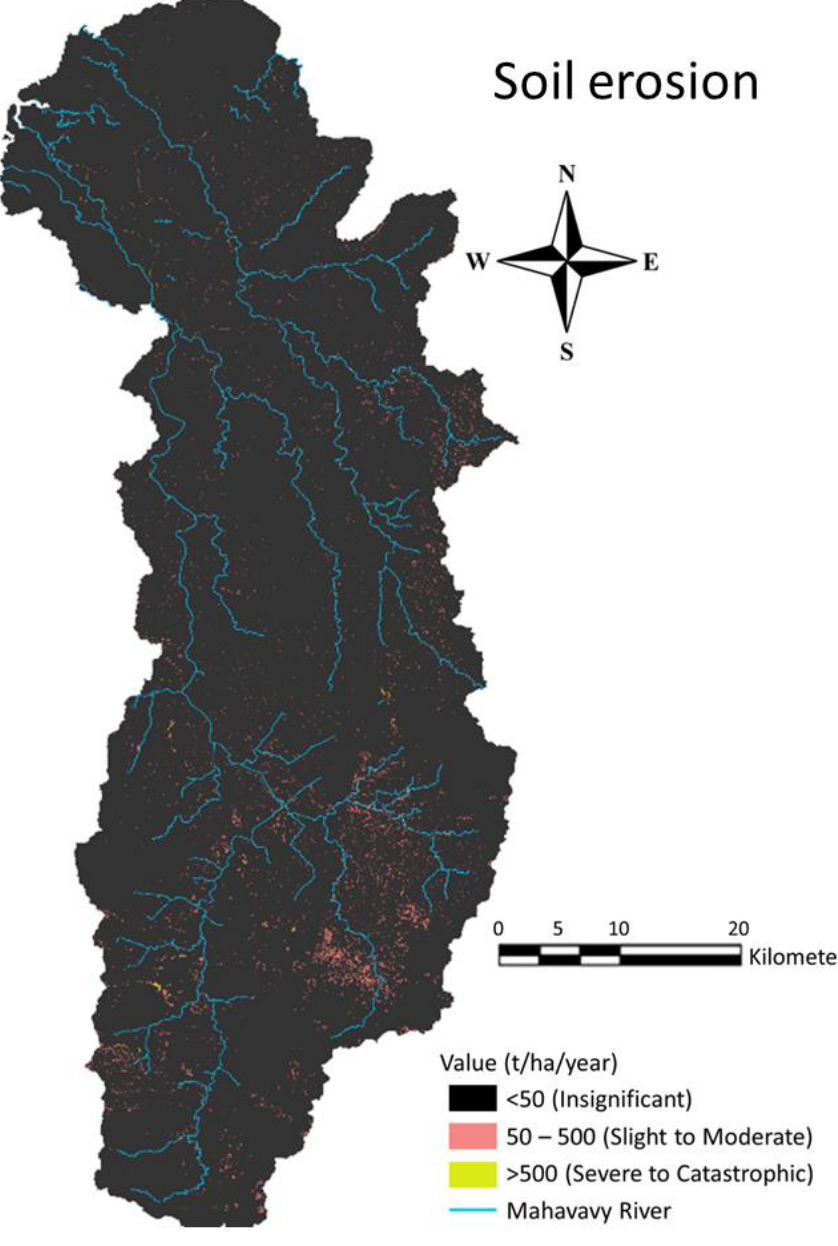
Figure 5. Soil erosion map of the watershed of Mahavavy. Table 6. Accuracy assessments for Land use/Land cover (LULC)